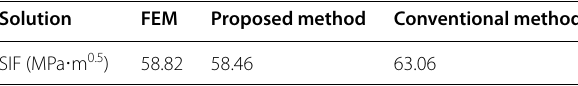
Table 7 Comparison of solutions obtained by different